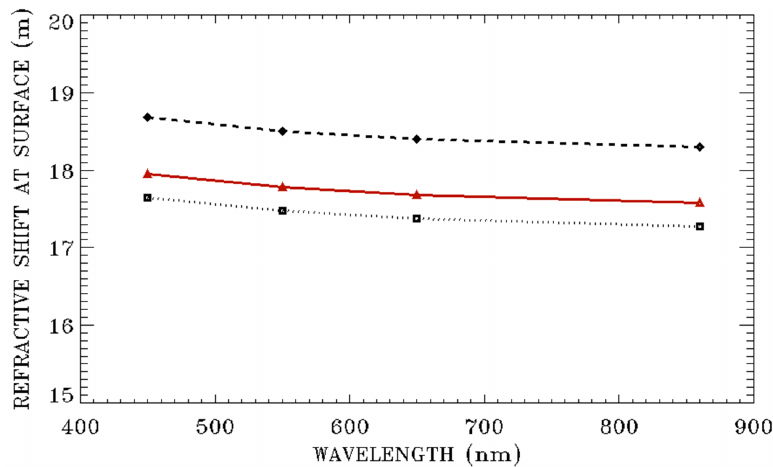
Figure 5. From the top to bottom curves—refractive surface pixel shifts as a function of wavelength for the sub-arctic winter, US 1976 standard, and tropical model atmospheres, respectively. The calculations are made for a satellite altitude of 500 km and a satellite downward view zenith angle of 60 degrees.